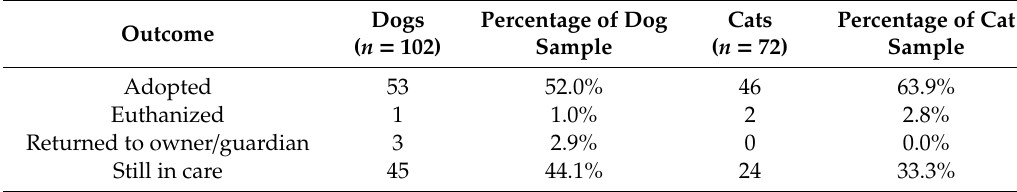
Table 9. Outcome for animals returned by number of animals and percentage of